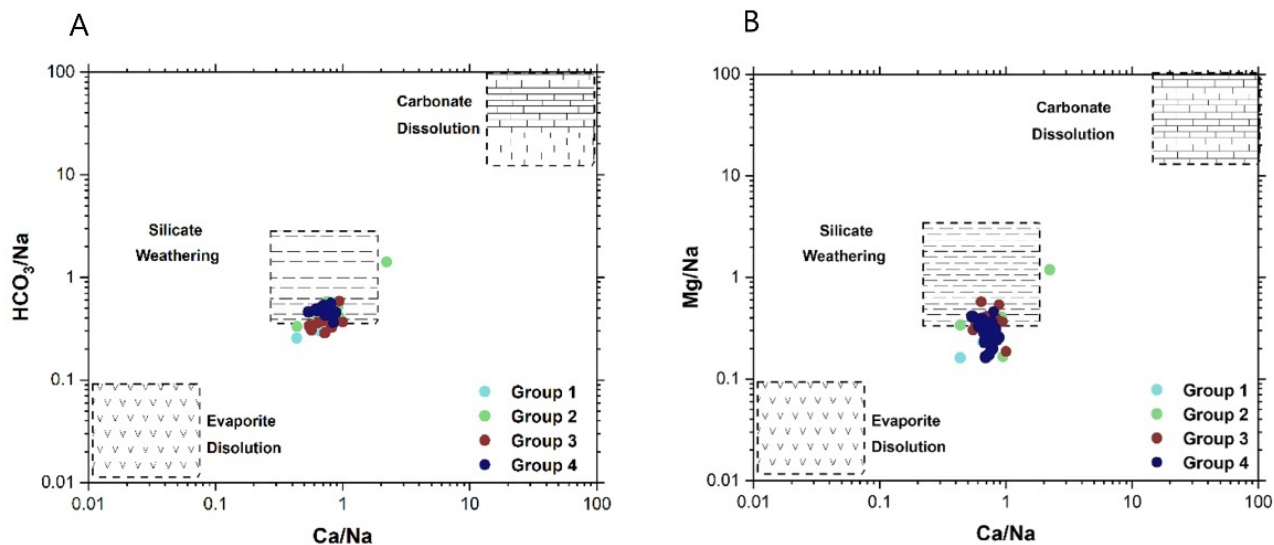
Figure 11. ( A ) Molar ratio in bivariate plots of Na + -normalized Ca 2+ and HCO 3 − , and ( B ) Na + -normalized Ca 2+ and Mg 2+ .